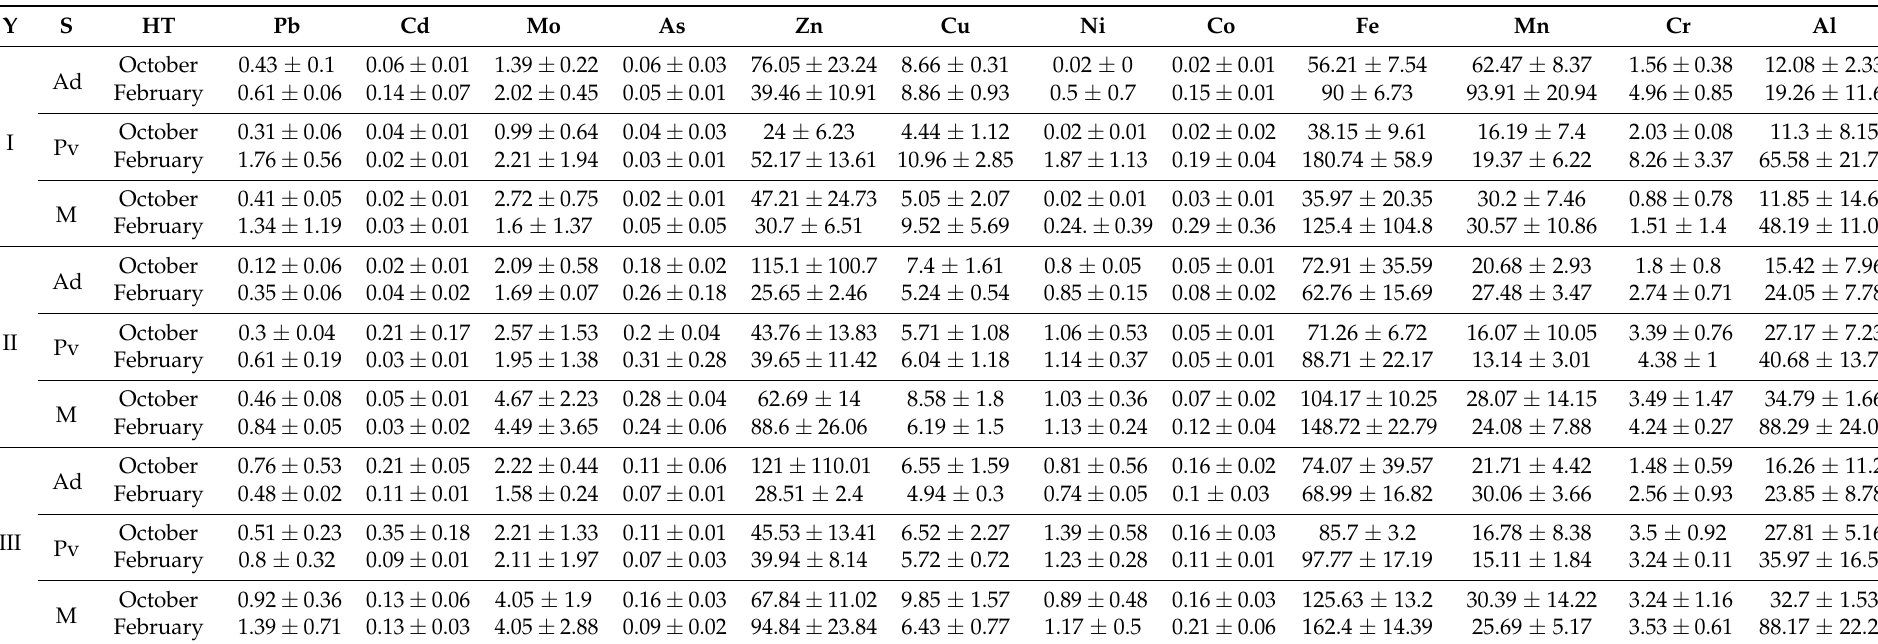
Table 2. ICP-MS analysis on 12 heavy metals in the harvested biomass of samples by Year (Y), Species (S) and Harvest Time (HT) expressed as mg/kg of DM. Each value is followed by its